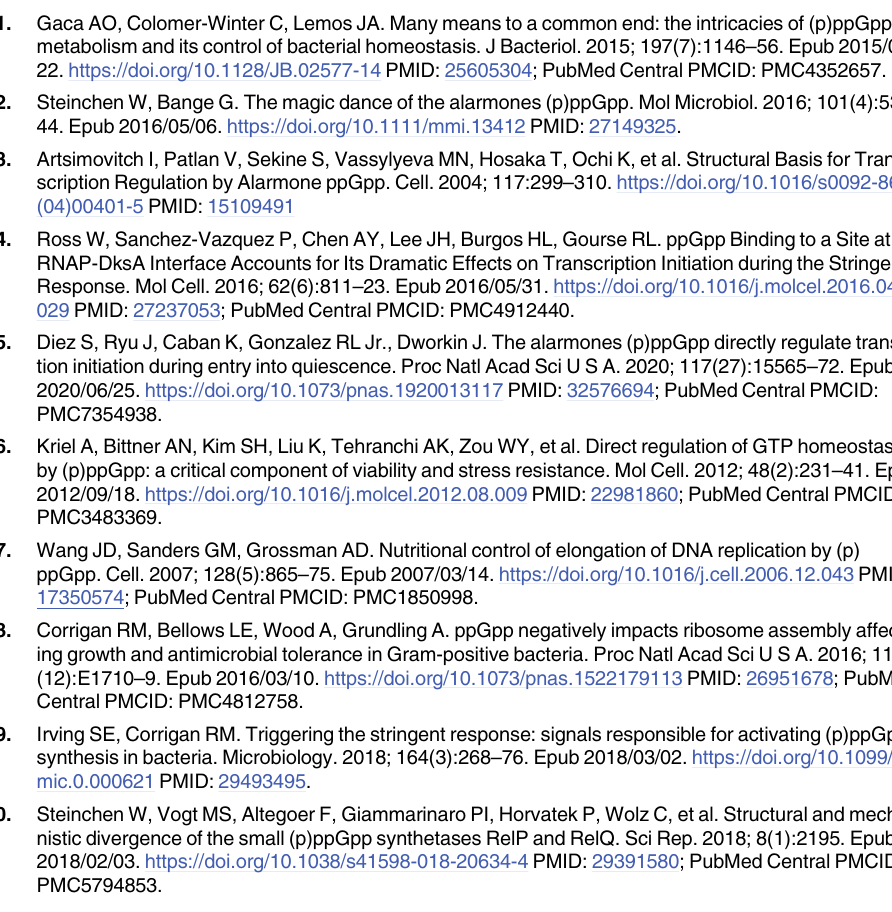
S2 Table. Strains used in this study. S3 Table. Oligonucleotides used in this